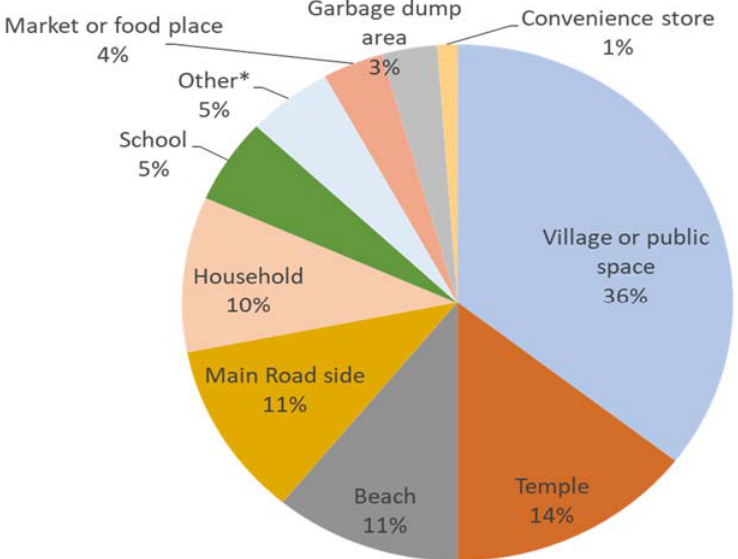
Figure 3. Frequency distribution of the habitat types of sites visited for oral vaccination in the 5 study areas ( n = 338). * other: park, rubber tree area, fishpond, and construction site.